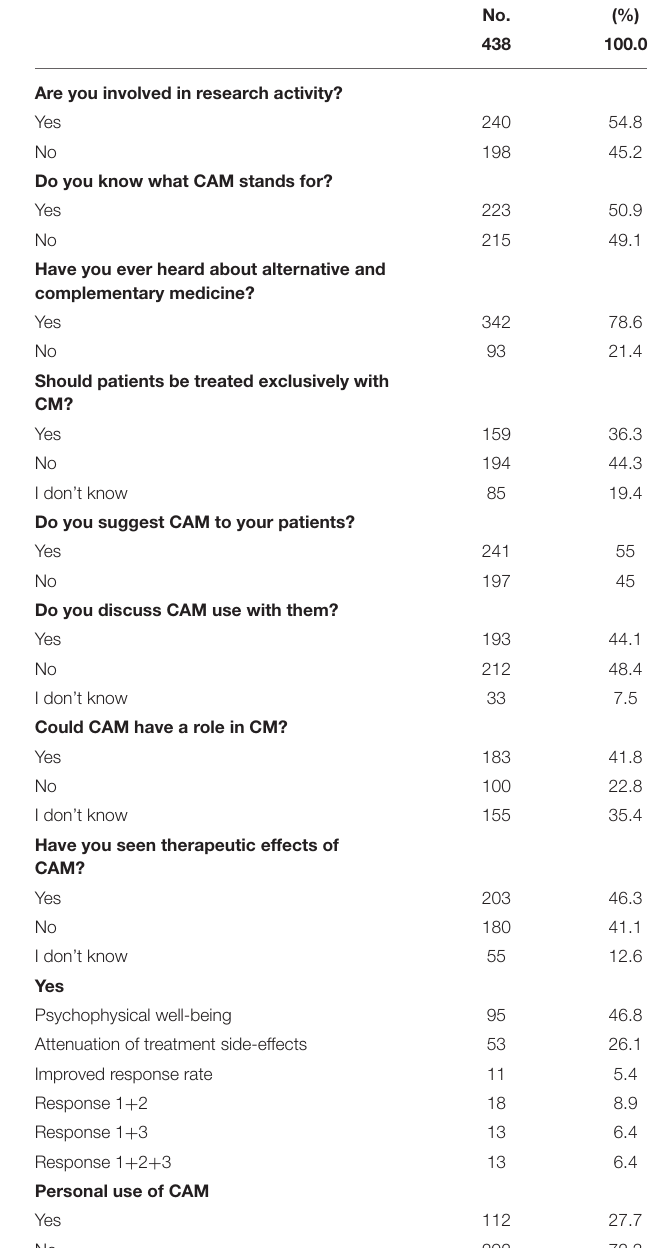
TABLE 2 | Personal and professional data of